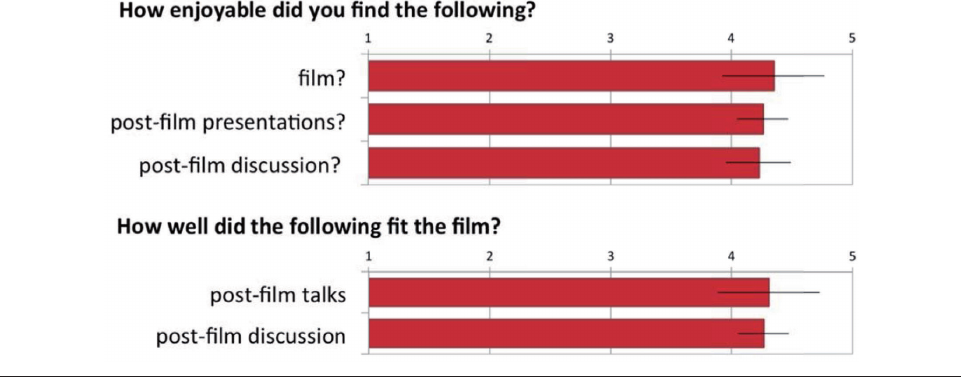
Figure 2: Post-event